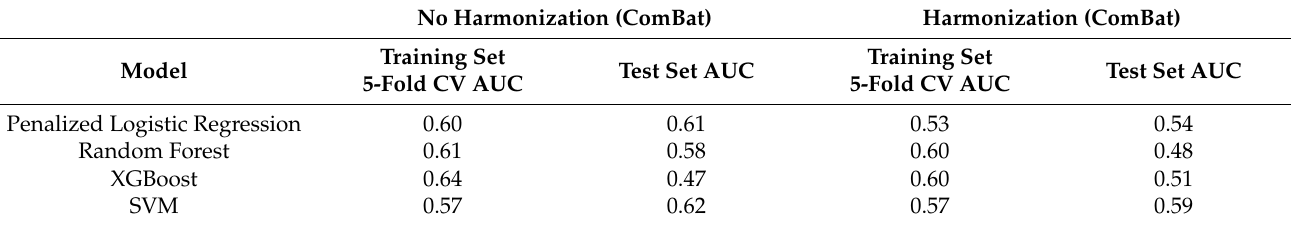
Table 3. Results of the clinical–radiomic models developed for the 1-year relapse classification. Mean AUC of the 5-fold cross-validation (CV) obtained during model training and AUC of the test set for the analysis without or with ComBat harmonization are